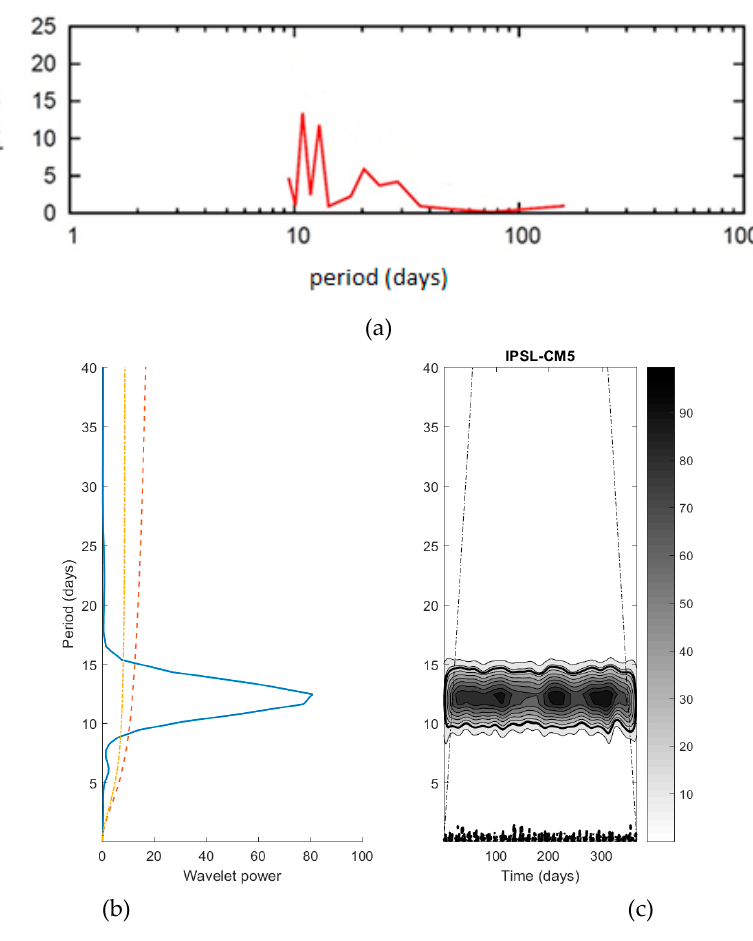
Figure 3. Same as in Figure 2, except with the IPSL-CM5 model power spectra.